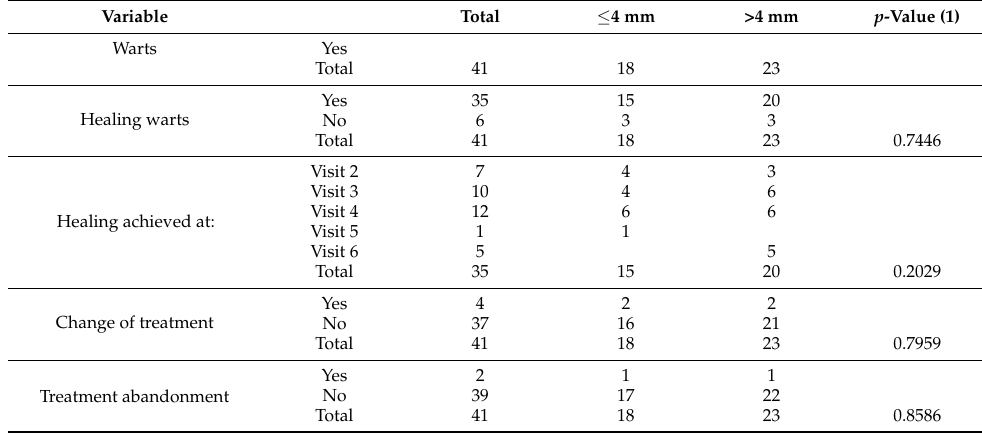
Table 3. Healed warts according to their